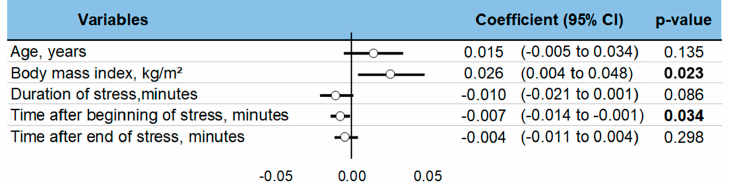
Figure 6. Meta-regressions—i.e., factors influencing changes in ghrelin levels following acute stress. Each variable's effect on the outcome is represented in the forest-plot by a dot on a horizontal line. The circles represent the coefficient for each variable, and the length of each line around the dots represents their 95% confidence interval (95CI). The black solid vertical line represents the null estimate (with a value of 0). Horizontal lines that cross the null vertical line represent non-significant variables on the outcome. Bold p-value are significant.